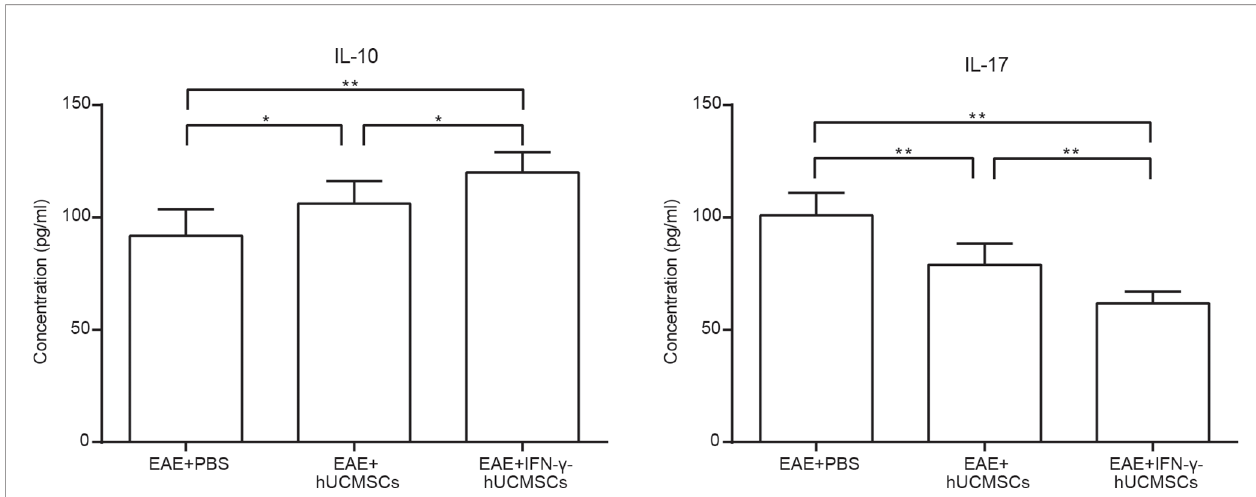
FIGURE 2 | Effects of transplantation of human umbilical cord mesenchymal stem cells (hUCMSCs) and IFN- g -primed hUCMSCs (IFN- g -hUCMSCs) on the levels of IL-10 and IL-17 in experimental autoimmune encephalomyelitis (EAE) mice. Cell transplantation could increase the concentration of IL-10 and reduce the concentration of IL-17, especially in the IFN- g -hUCMSCs transplantation group. * p < 0.05, ** p < 0.01 ( n = 8 per group).